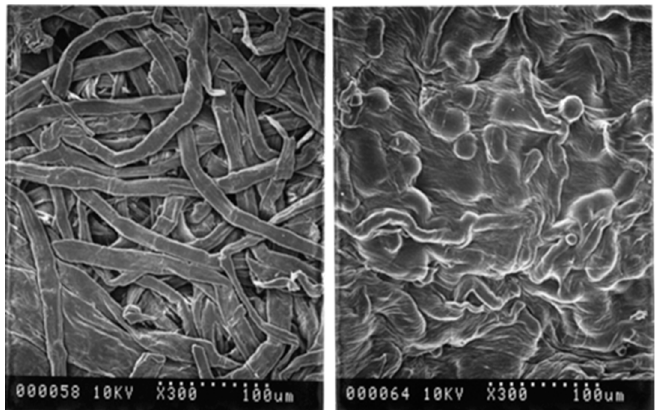
Figure 6. SEM micrographs of cellulose pulp fibers before ( left ) and after dissolution in [C 4 C 1 im] Cl ( right ). Reprinted with permission from [133]. Copyright (2020) American Chemical Society.